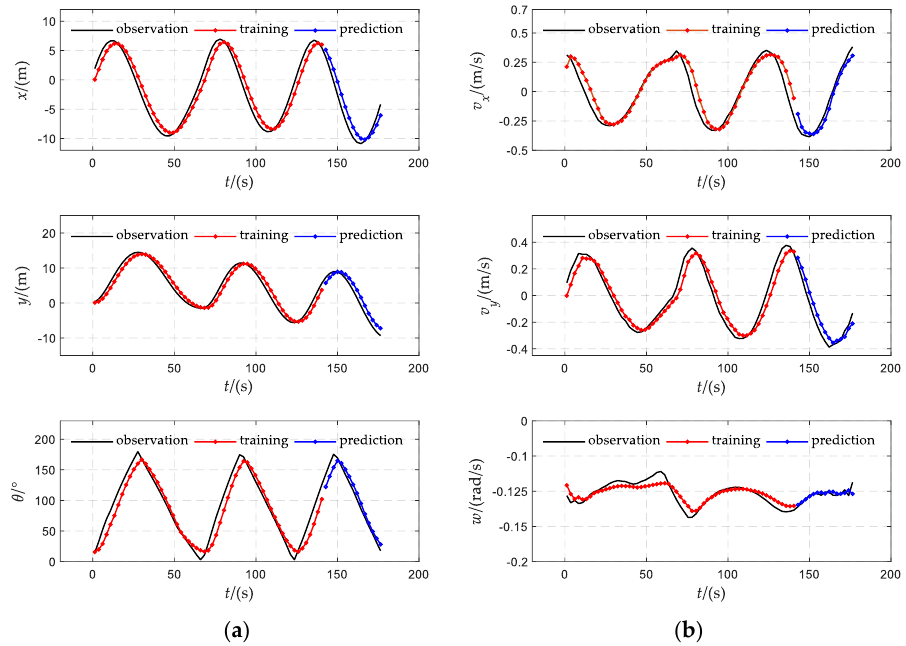
Figure 11. Results of training and prediction of constant driving force. ( a ) Results of training and prediction of position and yall angle; ( b ) Results of training and prediction of velocity and angular velocity.